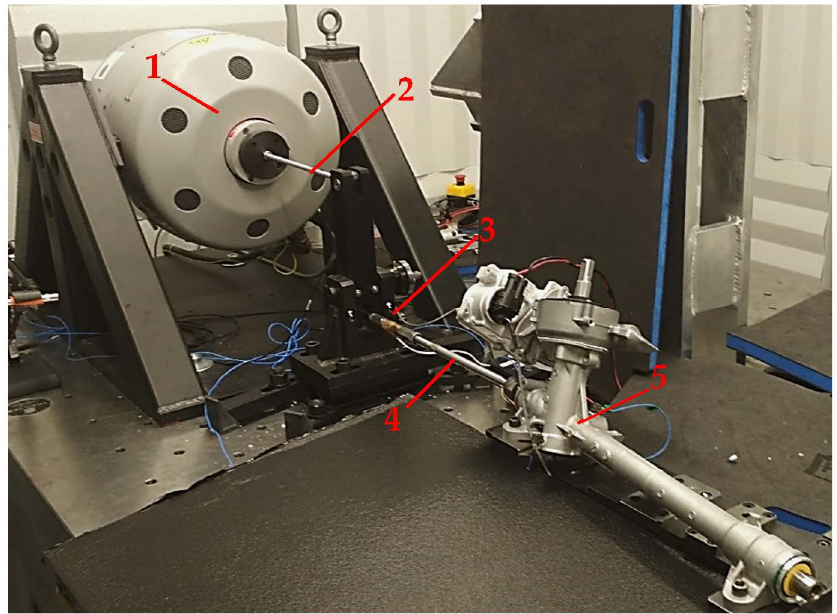
Figure 5. Test rig. 1—electrodynamic shaker, 2—stinger, 3—force sensor, 4—tie rod, 5—Tested EPS.